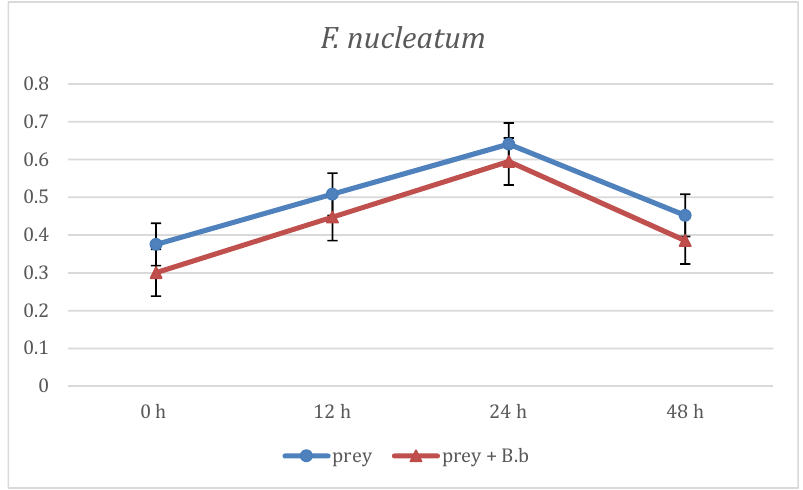
Figure 3. Predation activity of B. bacteriovorus against A. actinomycetemcomitans .